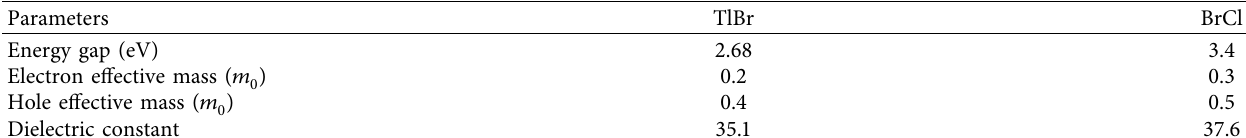
Table 1: Te parameters used in the calculations [20, 21].